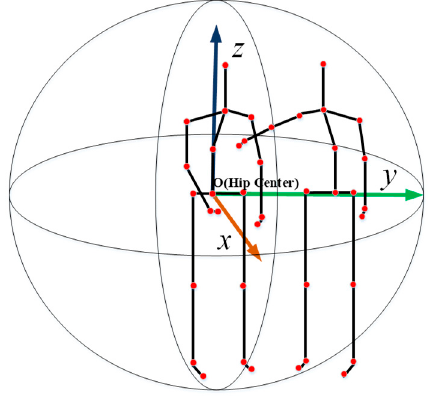
Figure 6. Human-centric coordinate system.